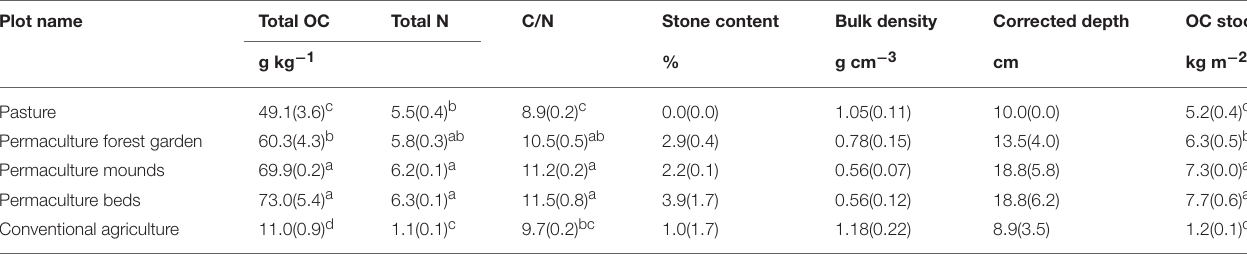
TABLE 3 | OC concentrations and stocks in bulk soil.